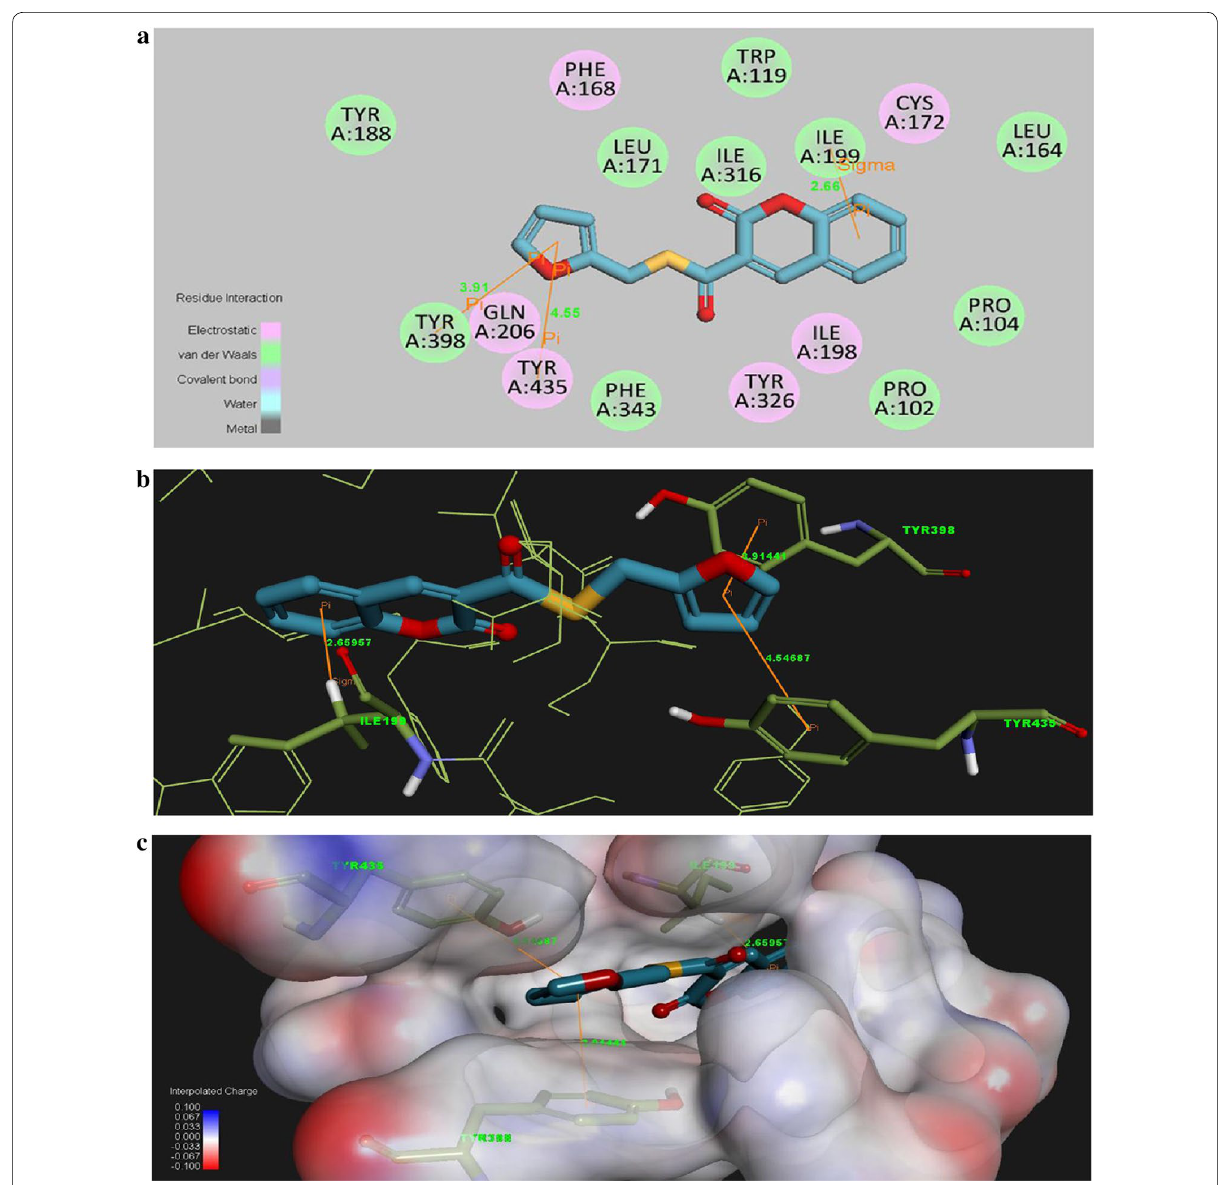
Fig. 60 Molecule docking of the compound C59 into the ligand binding model site of MAO-B ( a ). 2D Picture of binding ( b ). 3D Picture of binding ( c ). Molecule well fitted in the active pocket at the enzyme surface [92]